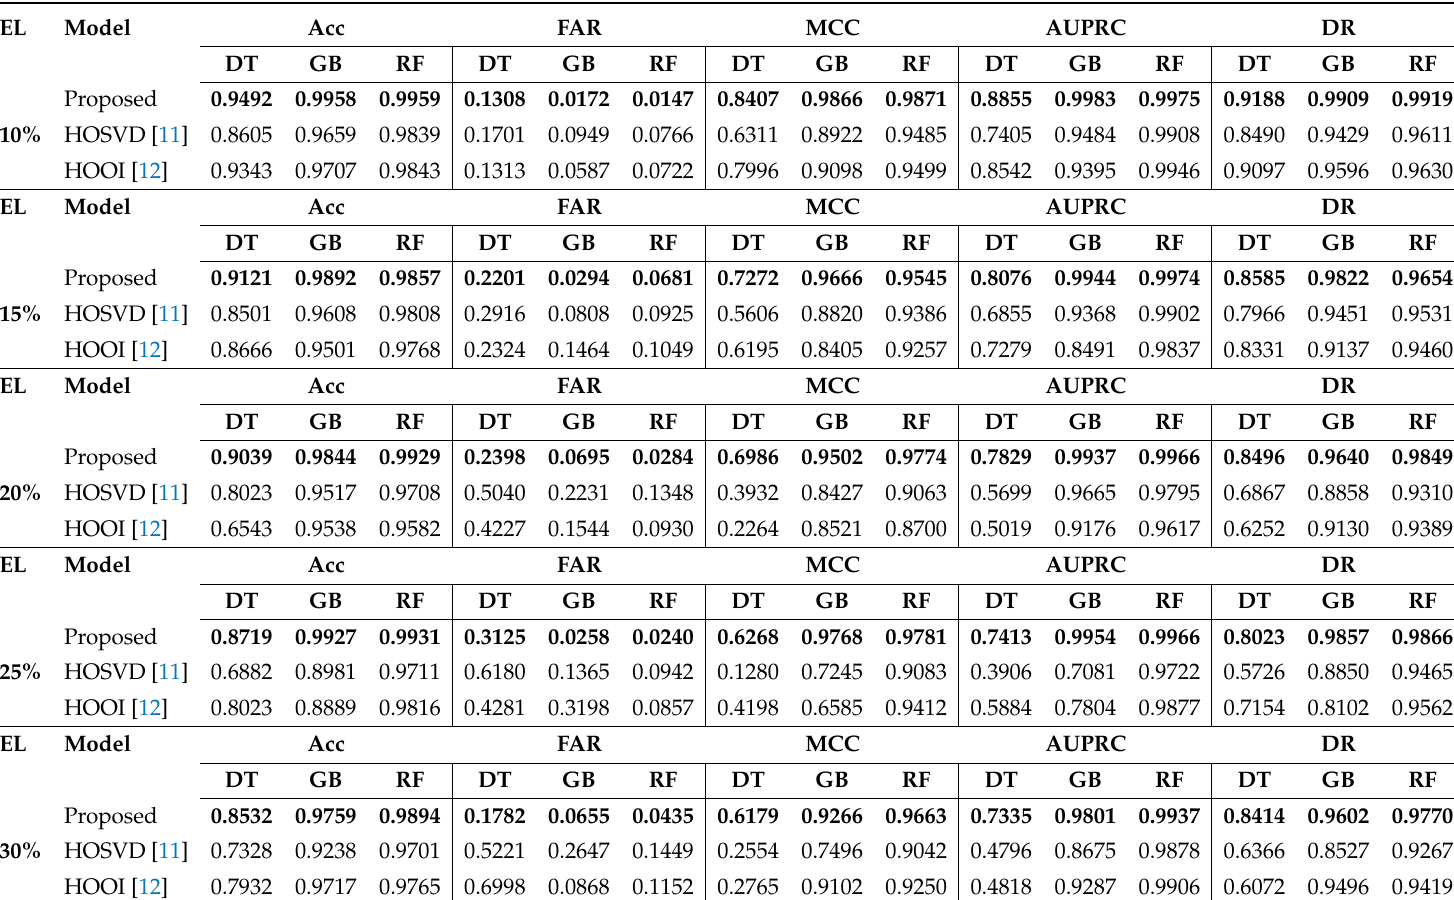
Table 4. Performance evaluation for different error